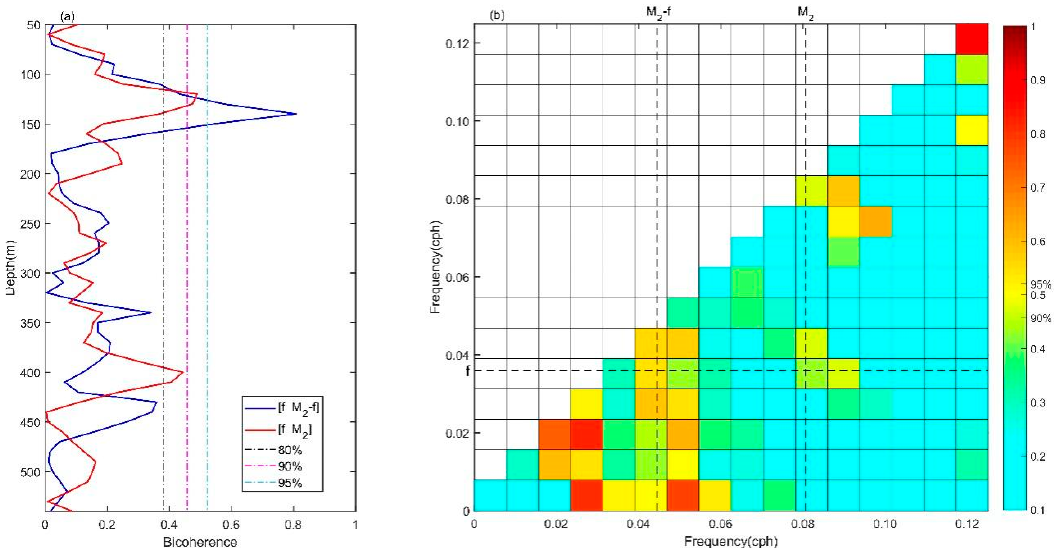
Figure 18. ( a ) Bicoherence values between near-inertial frequency f and M 2 – f (blue line) and M 2 (red line) frequency zonal residual currents plotted as a function of depth. Three vertical dashed lines denote the 80% (black), 90% (purple), and 95% (light blue) confidence intervals. ( b ) Bicoherence values of zonal residual currents at a depth of 130 m. The 90% and 95% confidence intervals are marked in the color bar.